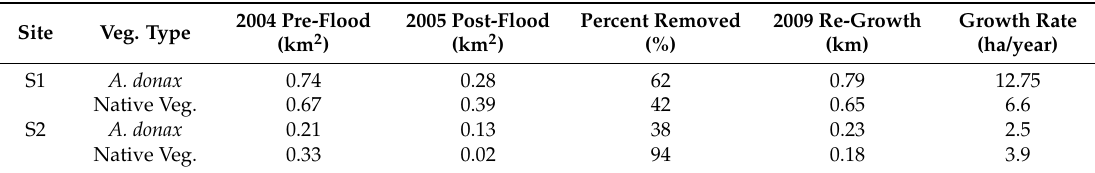
Table 7. Summary of effects of 2005 flood on the removal and re-growth of Arundo donax and native vegetation.